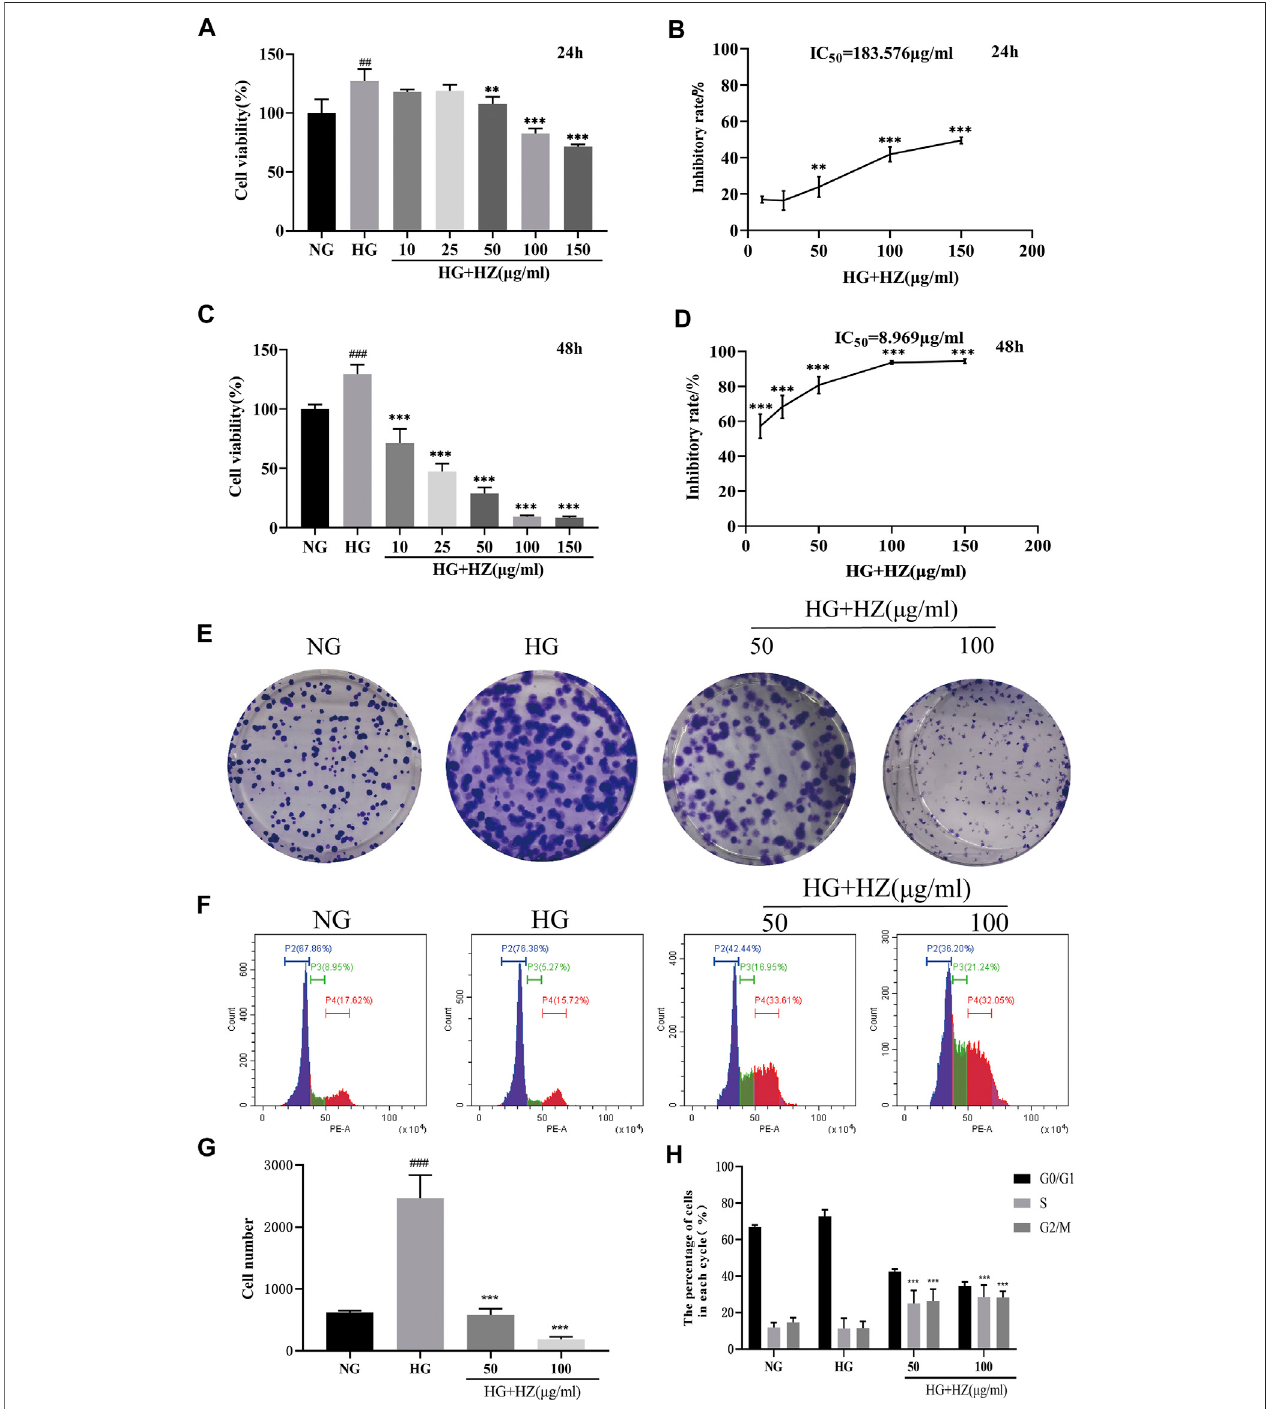
FIGURE2| EffectsofHZQMY ontheviabilityandproliferationofHRCECcellsexposedtohighglucose. Cellviability (A , C) andinhibitoryrateofcellproliferation (B , D) inducedbyvariousconcentrationsofHZQMYfor24and48 h,respectively. (E) HRCECswereculturedwithNG,HGandHG-HZ,respectively,for8 days (F) Cellcycle distribution was detected by fl ow cytometry. (G) The number of cell colonies was analyzed. (H) The percentage of cells in each phase was analyzed. ## and ### indicate p < 0.01 and p < 0.001, respectively, compared with NG group. ** and *** indicate p < 0.01 and p < 0.001, respectively, compared with HG group. HZ: HZQMY.